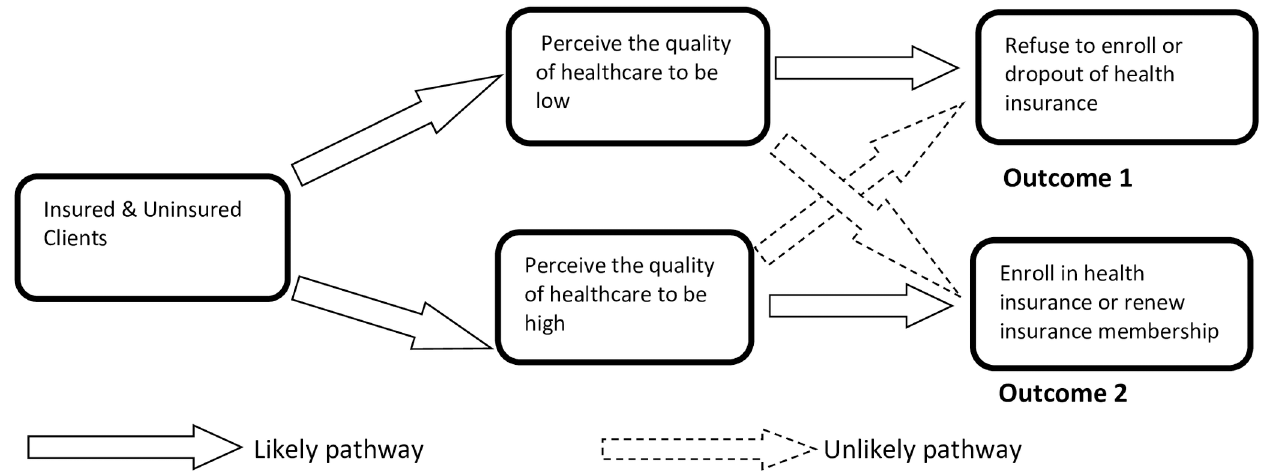
Fig 1. Conceptual frameworkof independence of quality perception on insurance status.